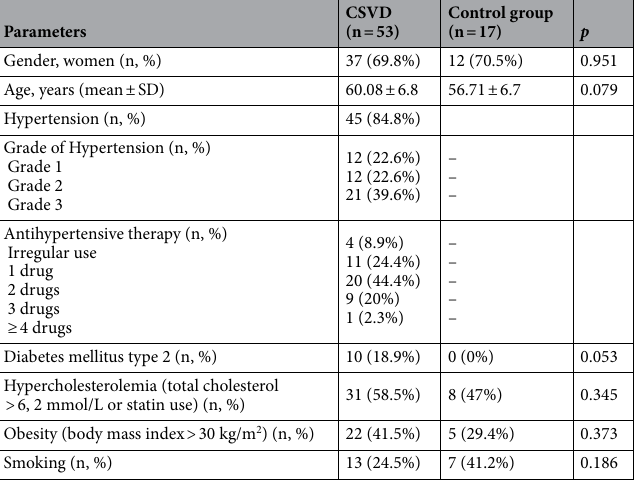
Table 1. Main demographic parameters and risk factors in patients with CSVD and